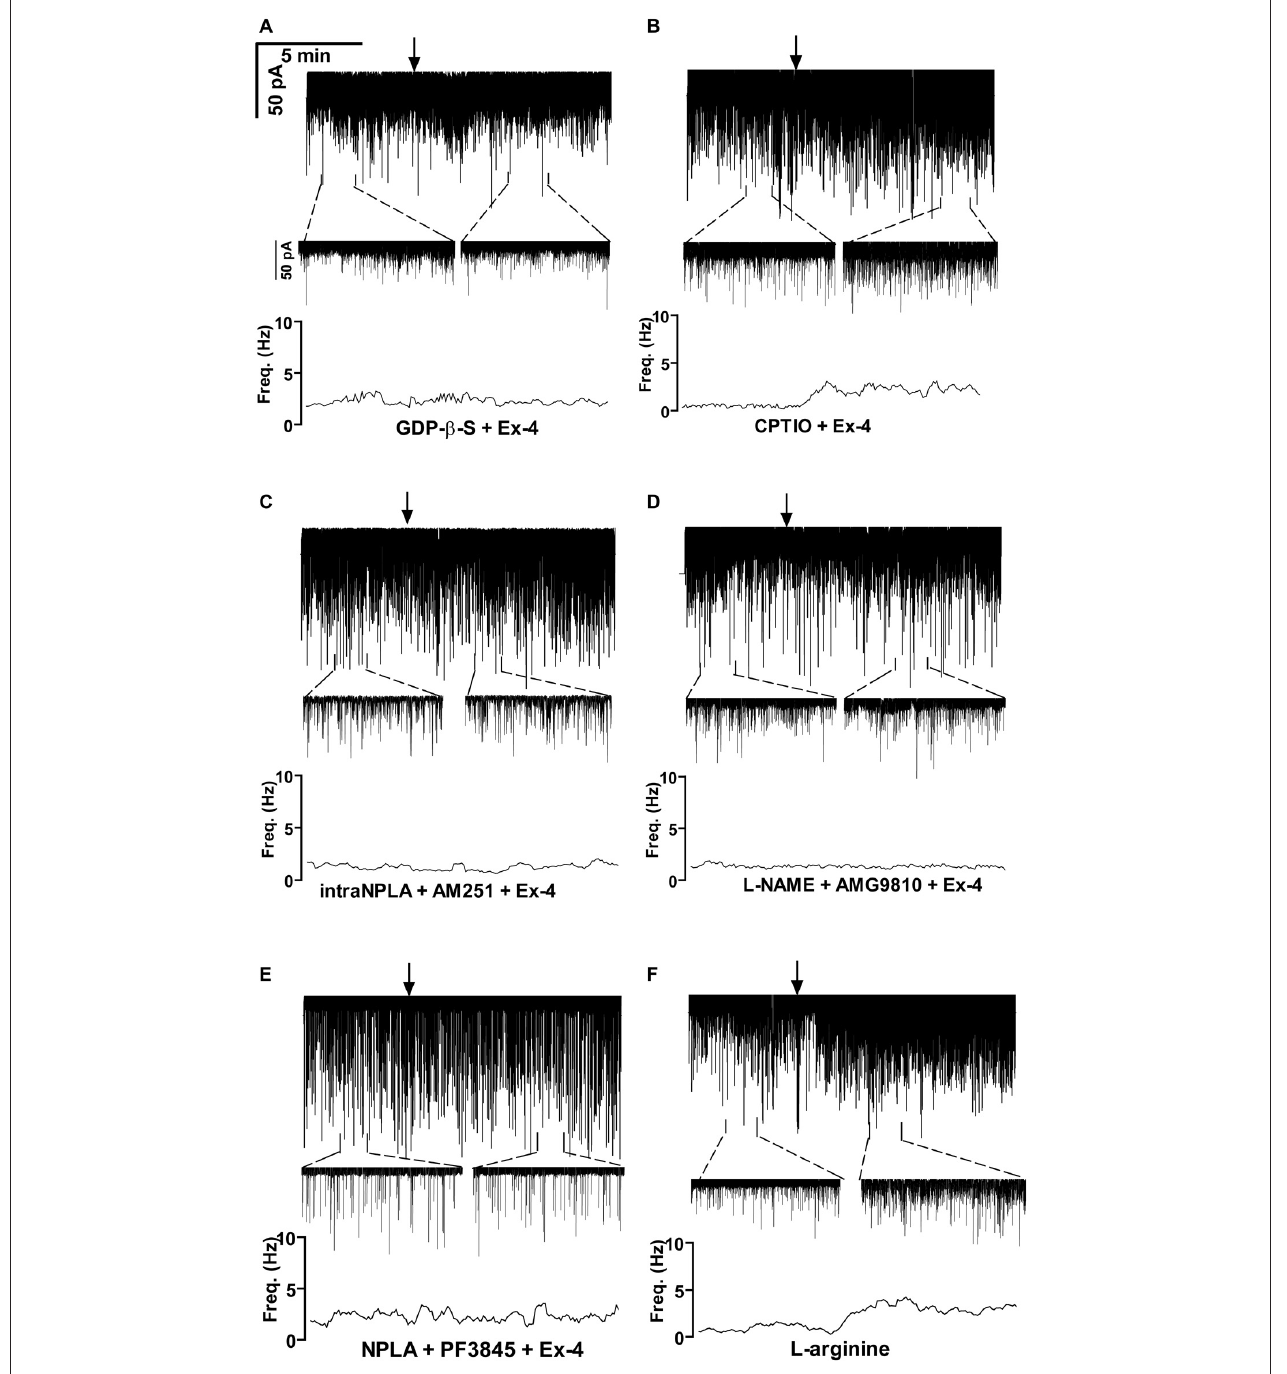
FIGURE 3 | Exendin-4 acts directly on GnRH neurons by activating a retrograde NO- and an anandamide-transient receptor potential vanilloid 1 (TRPV1) signaling mechanism. (A) Exendin-4 was unable to modify frequency of mPSCs when G-proteins were intracellularly blocked by GDP- β -S in the recorded GnRH neuron. (B) Partial inhibition was observed when the NO-scavenger 2-(4-carboxyphenyl)-4,4,5,5-tetramethylimidazoline-1-oxyl-3-oxide (CPTIO) was applied intracellularly in the GnRH neuron. (C) Full inhibition was achieved when neuronal NO synthase (nNOS) was inhibited by the intracellularly applied N 5 -[Imino(propylamino)methyl]-L-ornithine hydrochloride (NPLA) and the endocannabinoid pathway was blocked by AM251. (D) Simultaneous blocking of NOS by L-NAME and intracellular inhibition of the TRPV1 receptor by 2E-N-(2,3-Dihydro-1,4-benzodioxin-6-yl)-3-[4-(1,1-dimethylethyl)phenyl]-2-Propenamide (AMG9810) in the GnRH neuron abolished the effect of Exendin-4. (E) Inhibition of both nNOS by NPLA and anandamide degradation by PF3845 resulted in full elimination of action of Exendin-4. (F) The NO-donor L-arginine elevated frequency of the mPSCs. Arrows show the onset of Exendin-4 or L-arginine administration.